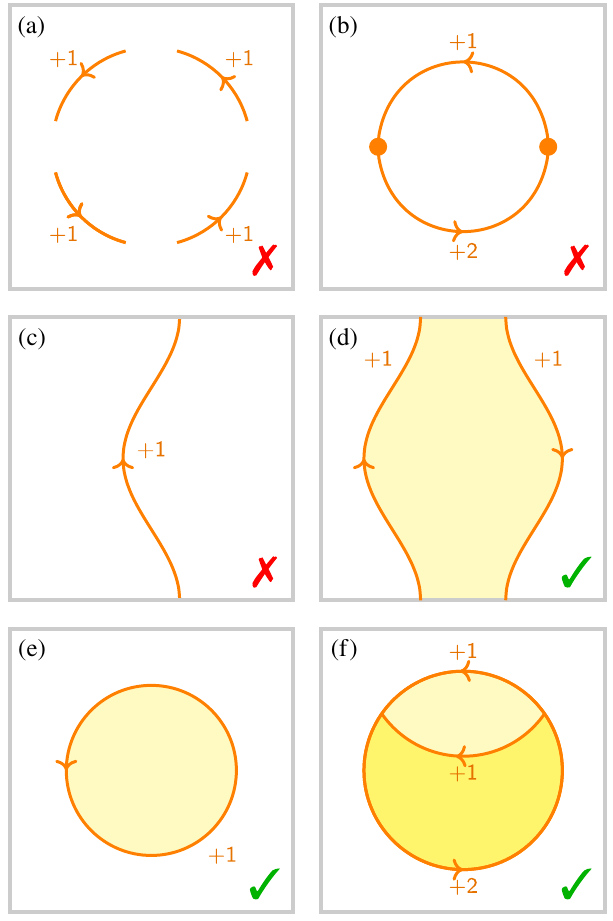
FIG. 2. Allowed ( ✓ ) and disallowed ( ✗ ) Fermi-surface con- figurations in a two-dimensional Brillouin zone. Each Fermi- surface segment has an associated anomaly coefficient m shown by the number next to the segment. An arbitrary choice of orientation of the segment (denoted with arrows) determines the convention for the sign of m . For allowed configurations, it is always possible to define an integer function n ð k Þ — depicted here by the different shading colors of different regions — such that the boundary between two regions carries the anomaly coefficient determined by the difference of n ð k Þ between the two regions. In a Fermi gas, n ð k Þ represents the number of occupied bands at the point k